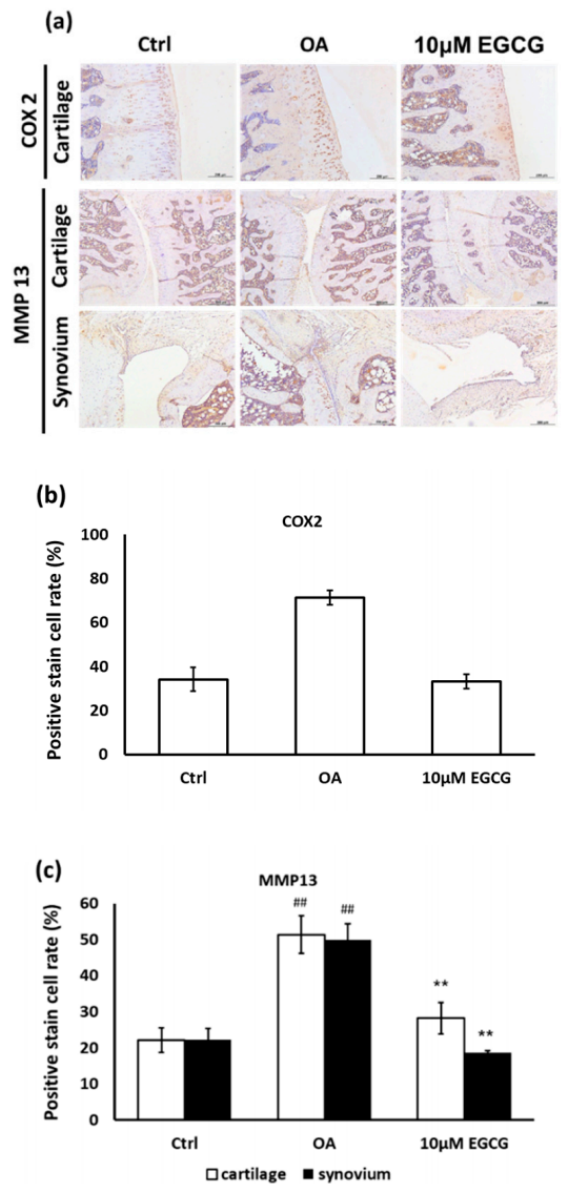
Figure 5. Immunohistochemistry (IHC) of cyclooxygenase-2 (COX-2) and matrix metalloproteinases- 13 (MMP-13) in the articular cartilage of control, osteoarthritis (OA), and OA + EGCG joints. ( a ) The representative micrographs of IHC analysis for COX-2 and MMP-13. Magnification: 10 × . ( b ) The quantitative analysis of immunostained COX-2. Magnification: 40 × . ( c ) The quantitative analysis of immunostained MMP-13 Magnification: 40 × . Sections of osteoarthritic cartilage demonstrated more staining of COX-2 and MMP-13 protein compared to samples from control group. In the EGCG-treated joint, the densities of immunostained COX-2 and MMP-13 were significantly reduced. (** p < 0.01 OA vs. control; ## p < 0.01 OA vs.